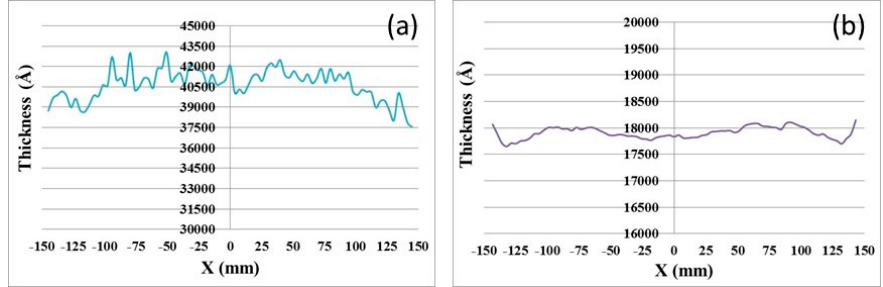
Figure 2. ( a ) Cu thickness profile before CMP process; ( b ) tetraethyl orthosilicate (TEOS) thickness profile after CMP process.